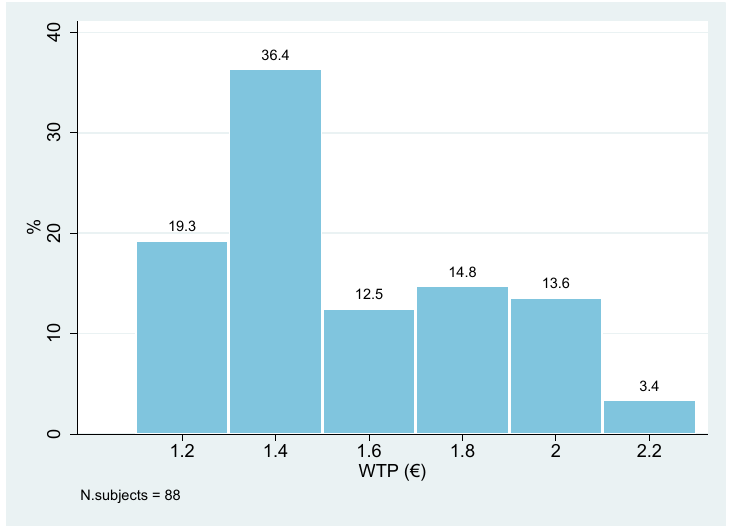
Figure 3. Contingent valuation results: histogram of declared WTP for a 90 g tin of Chianina meat by respondents with a positive WTP. Percentages calculated on 88